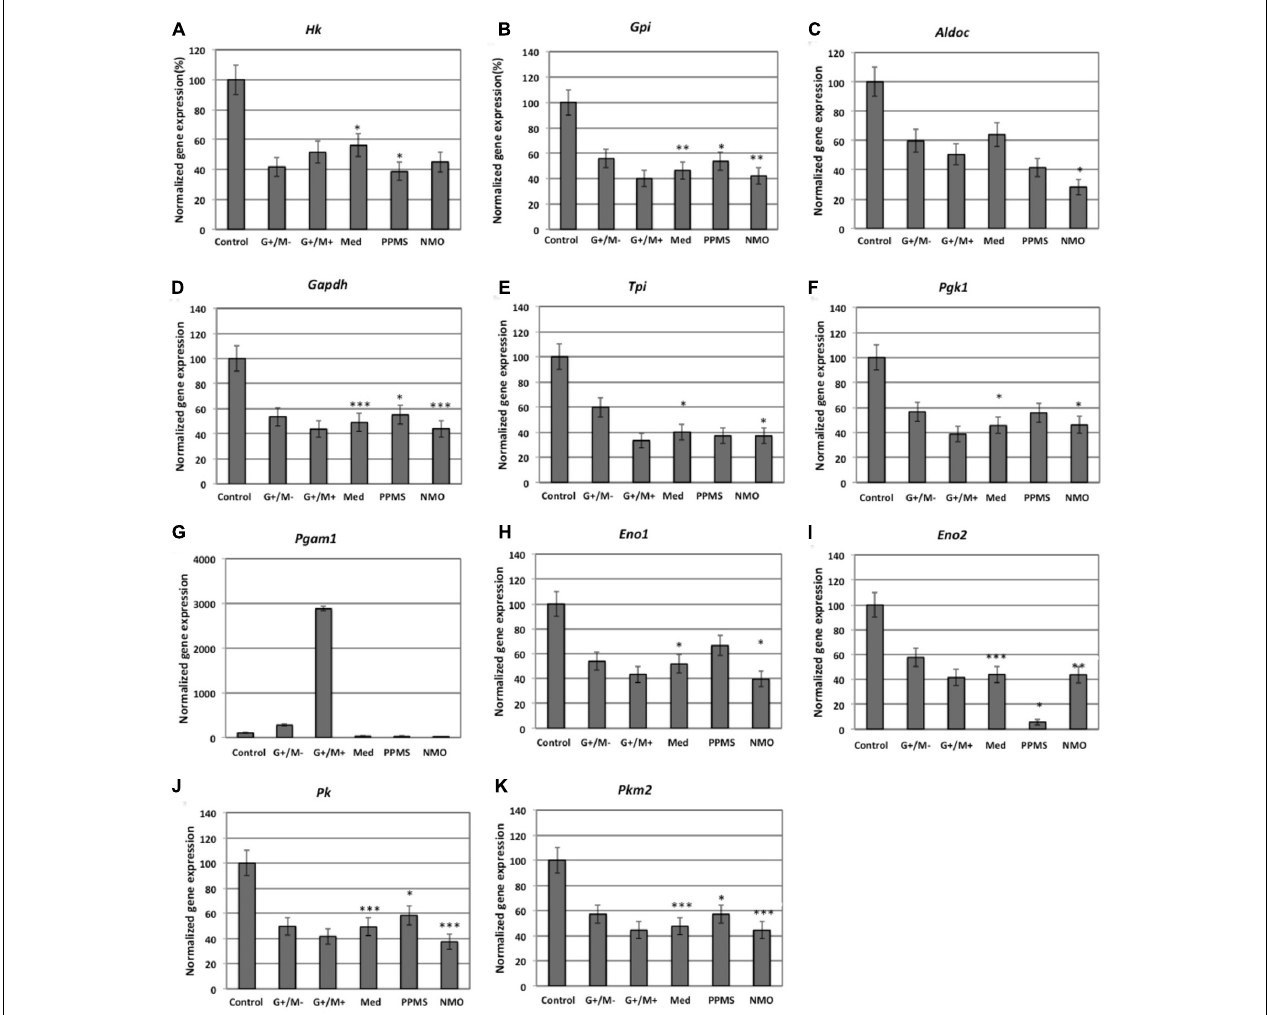
FIGURE 2 | Normalized expression of (A) Hk ; (B) Gpi ; (C) Aldoc ; (D) Gapdh ; (E) Tpi ; (F) Pgk1 ; (G) Pgam1 ; (H) Eno1 ; (I) Eno2 ; (J) Pk ; (K) Pkm2 genes involved in glycolytic pathway in OPCs treated with CSF of MS and NMO patients related to gene expression in OPCs treated with CSF of non-inflammatory neurological controls. OPCs: oligodendrocyte progenitor cells; Control: Neurons treated with CSF of non-inflammatory neurological controls; G + /M − and G + /M + : types of inflammatory MS; Med: Medullary MS; PP: Primary progressive multiple sclerosis; NMO: Neuromyelitis Optica. Four microarrays were used in each MS or NMO type of